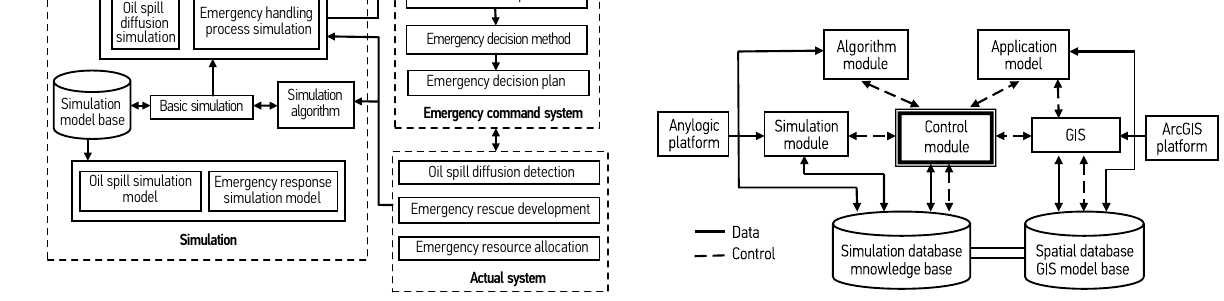
Fig. 2. Simulation model for oil spill emergency